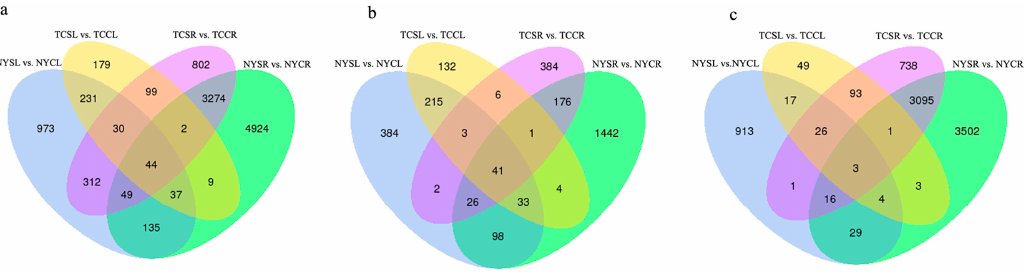
Figure 3. Statistics of differentially expressed genes (DEGs). ( a ) all of DEGs, ( b ) upregulated DEGs, and ( c ) downregulated DEGs in various NY and TC comparison groups under salt stress and control conditions.